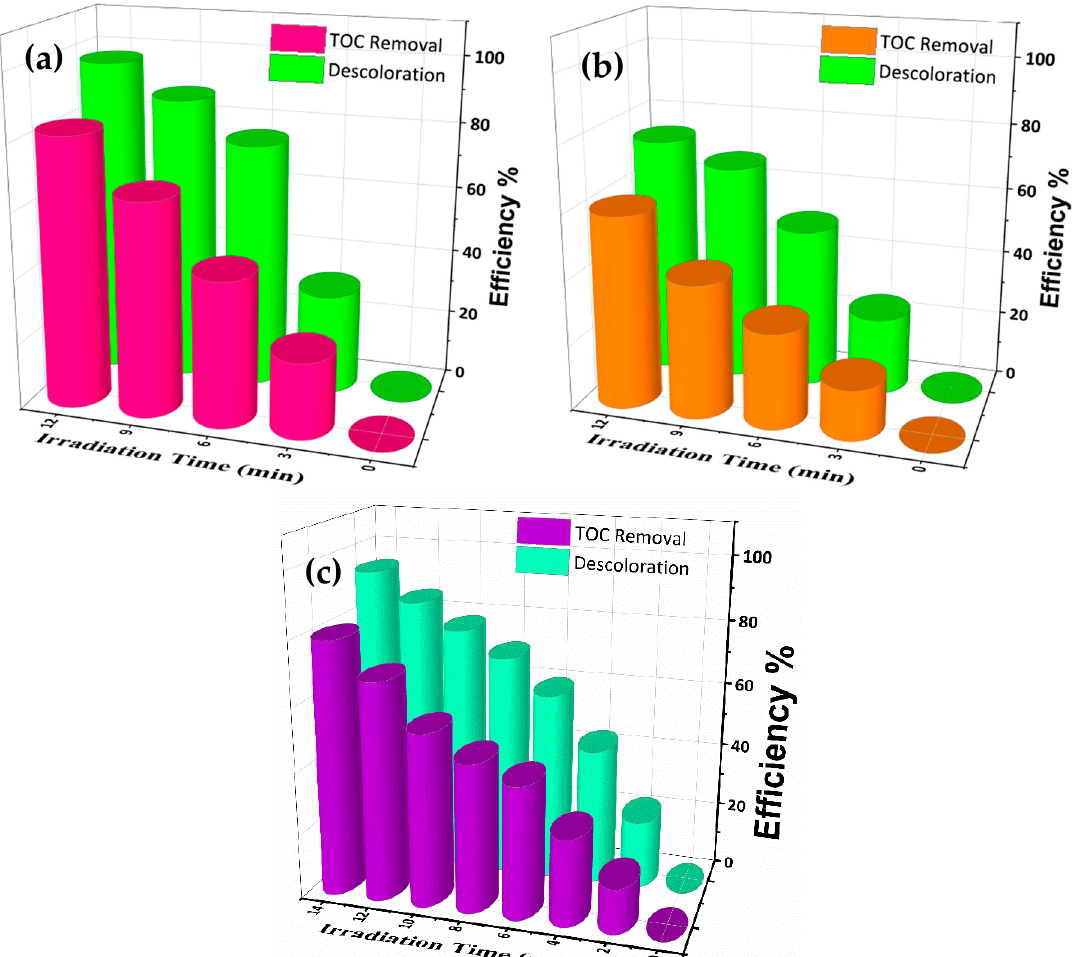
Figure 14. TOC removal and discoloration as a function of time of ( a ) Rhodamine B, ( b ) Orange G and ( c ) RhB-MB in the presence of the BiP-500 photocatalyst.